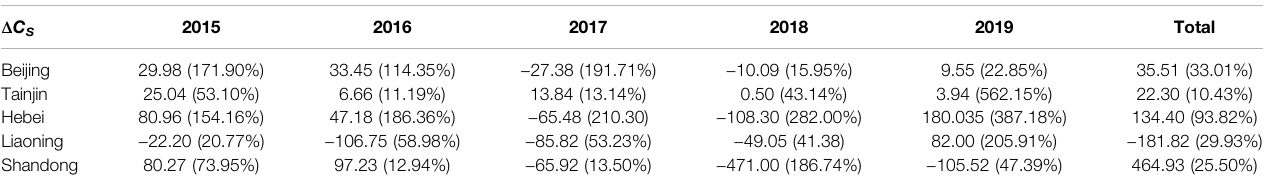
The values in parentheses indicate the contribution rate of each in fl uencing factor.